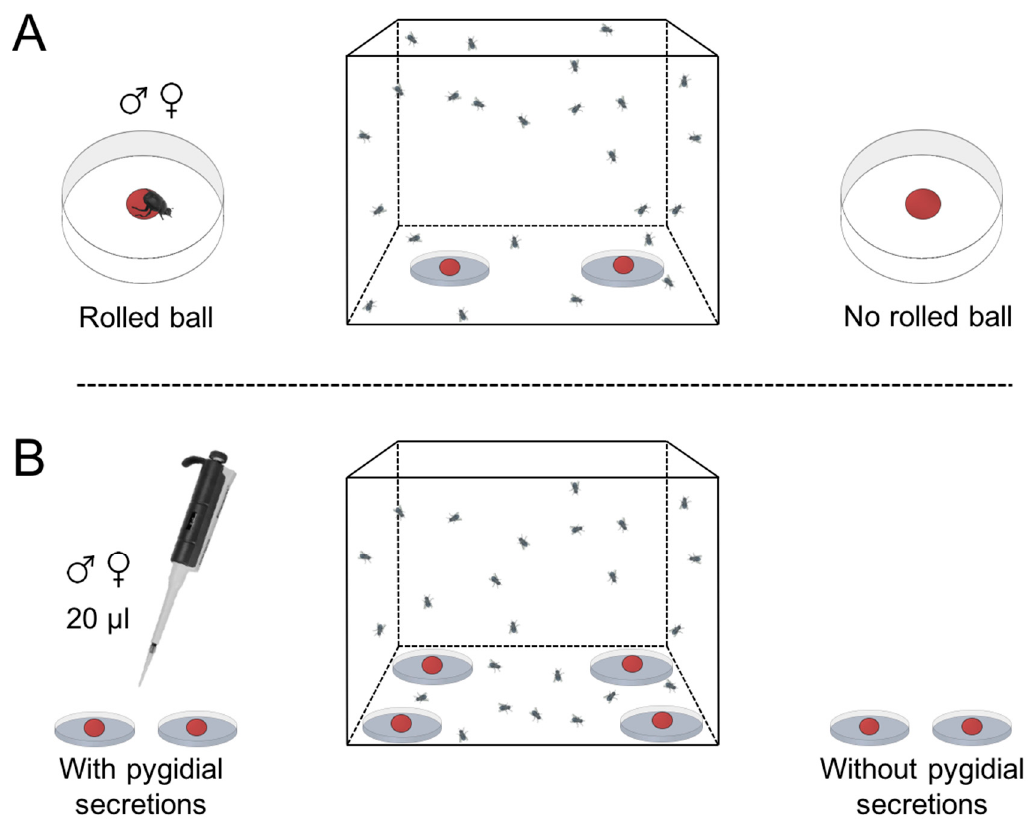
Figure 2. The experimental design to test the oviposition preference of Lucilia cuprina when there was a choice of ( A ) balls rolled by either male or female Deltochilum furcatum or ( B ) food balls impregnated with 20 µ L of male and female pygidial secretions and untreated balls.